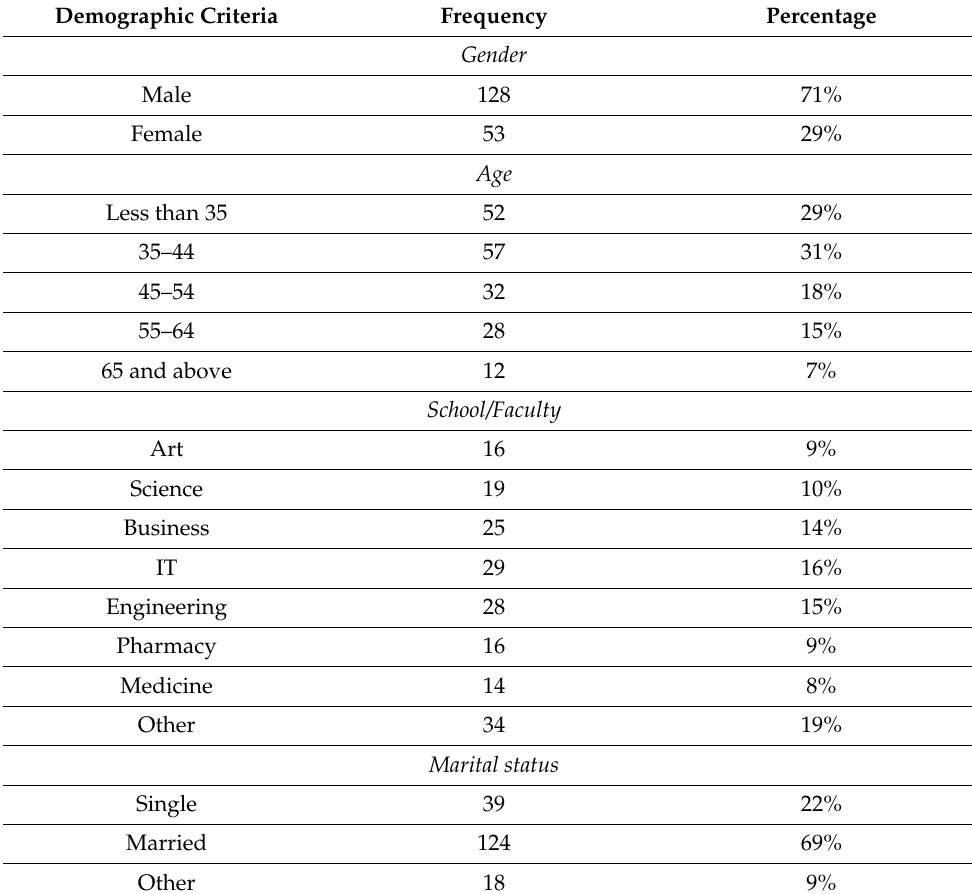
Table 2. Demographic characteristics of the